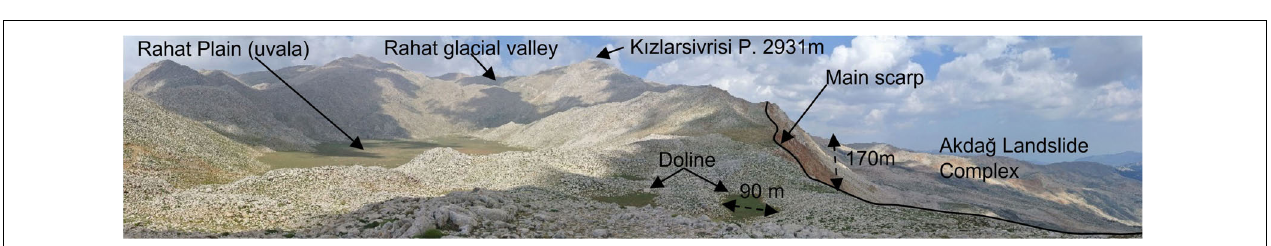
FIGURE 11 | Panoramic view of Rahat glacial valley, Rahat plain (uvala), and main scarp of the Akdag landslide south of Akdag Massif (in Figure 4 , the viewpoints of photographs are